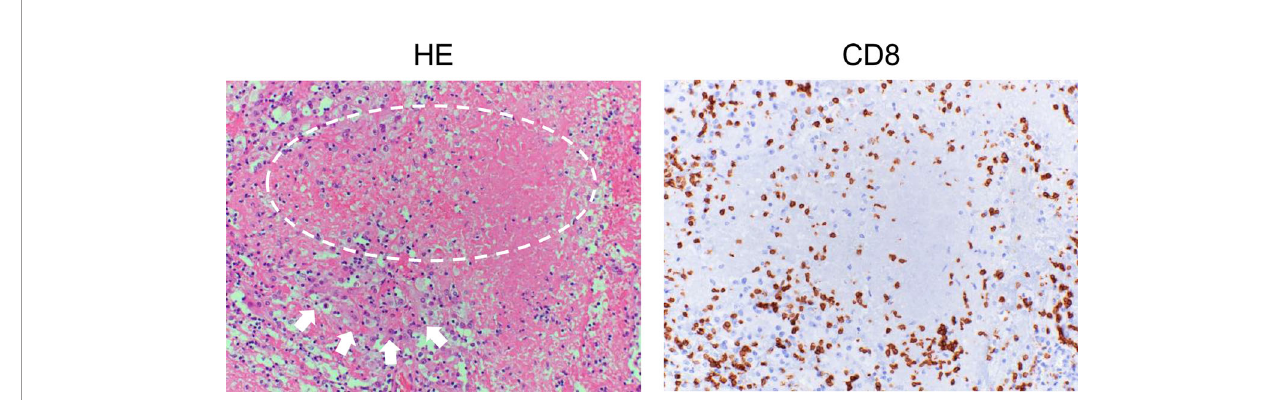
FIGURE 2 | Histology of renal cell carcinoma after the administration of immune checkpoint inhibitors. Left: Hematoxylin and eosin (HE) staining of a case of renal cell carcinoma (arrows) after ipilimumab and nivolumab therapy. Typical morphological changes in apoptosis such as shrinkage of the cell and/or fragmentation into apoptotic bodies are not seen (circle). Right: Immunohistochemical staining for CD8 in a serial section. Numerous CD8-positive cells have in fi ltrated